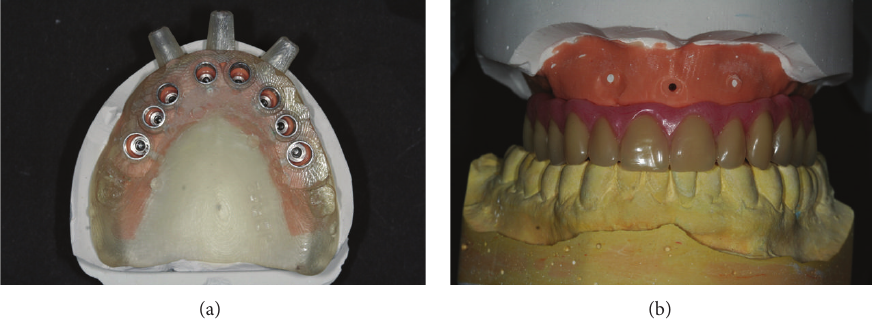
Figure 4: (a) Implant replicas are combined with the surgical template to obtain a master model. (b) The full-arch rehabilitation is realized on this model before the surgical